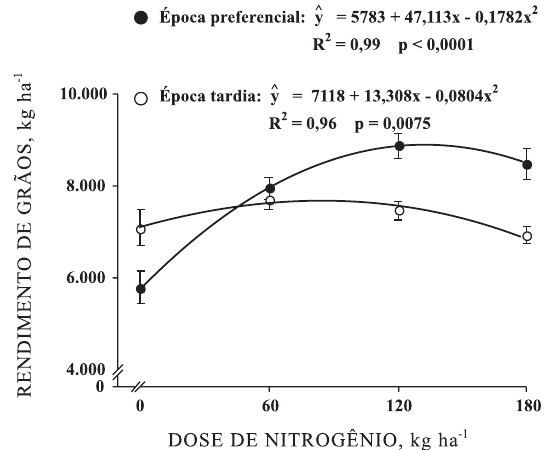
Figura 4. Rendimento de grãos de arroz irrigado para épocas de semeadura preferencial (novembro) e tardia (dezembro), em função da dose de nitrogênio aplicada em cobertura, na média de quatro densidades de semeadura. Barras verticais representam o erro-padrão da